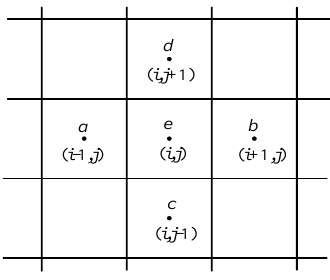
Figure 5. The corresponding positional relationship between the coefficients and the grids. Equation (6) is the difference equation of the grid ( i , j ).